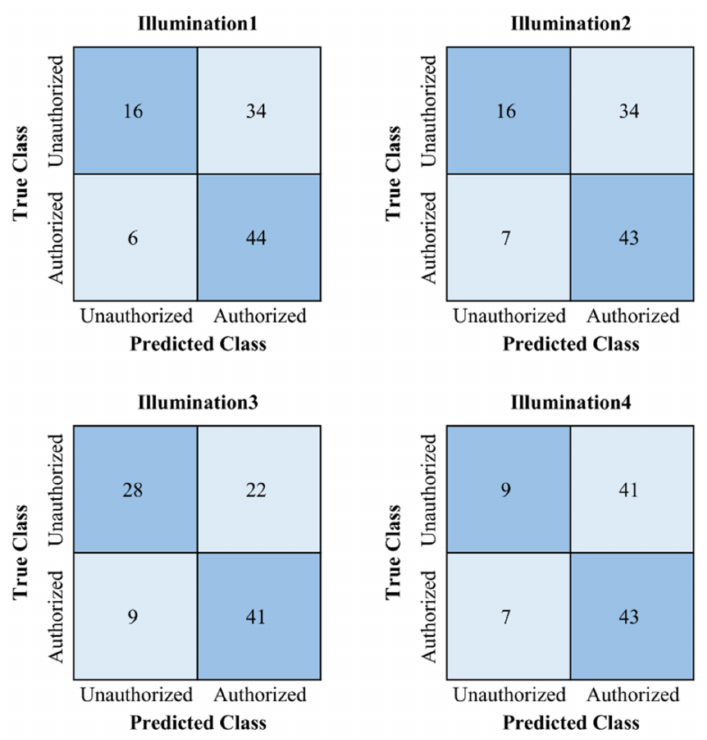
Figure 20. The confusion matrix of GoogLeNet under different